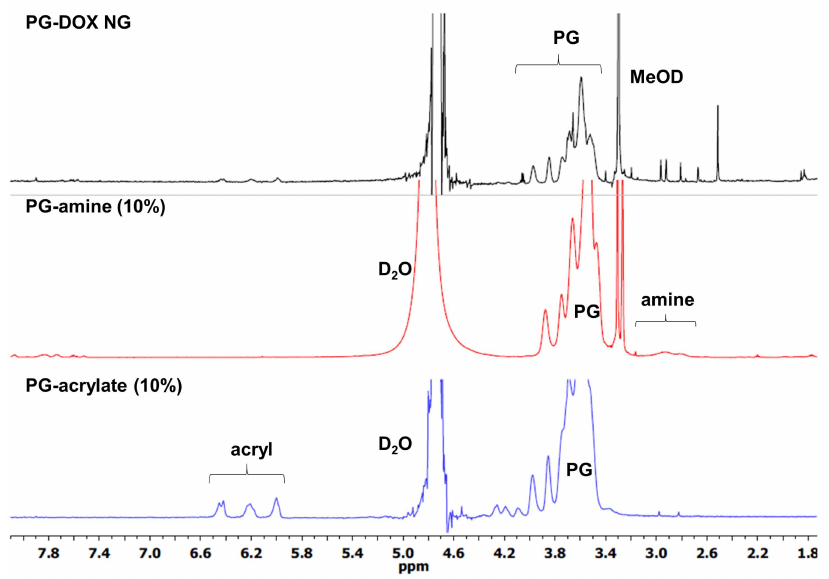
Figure 4. 1 H-NMR spectra of macromonomers (D 2 O) and PG-DOX NG (MeOD).